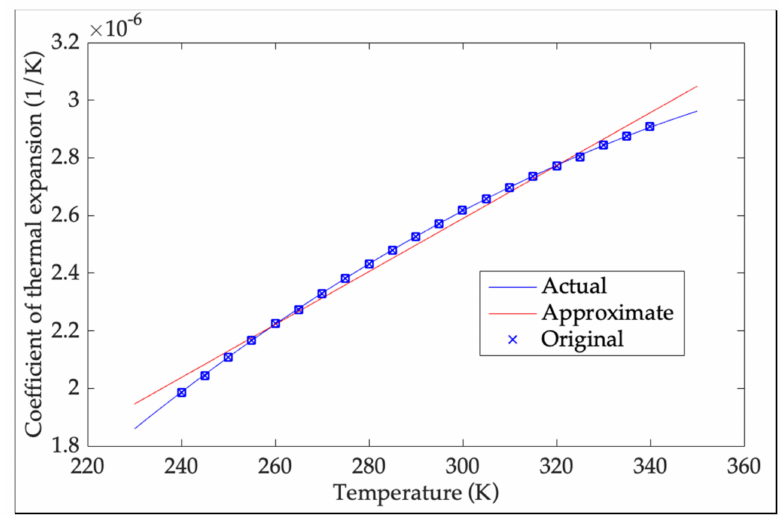
Figure 2. Comparison of CTE variation in actual and approximate